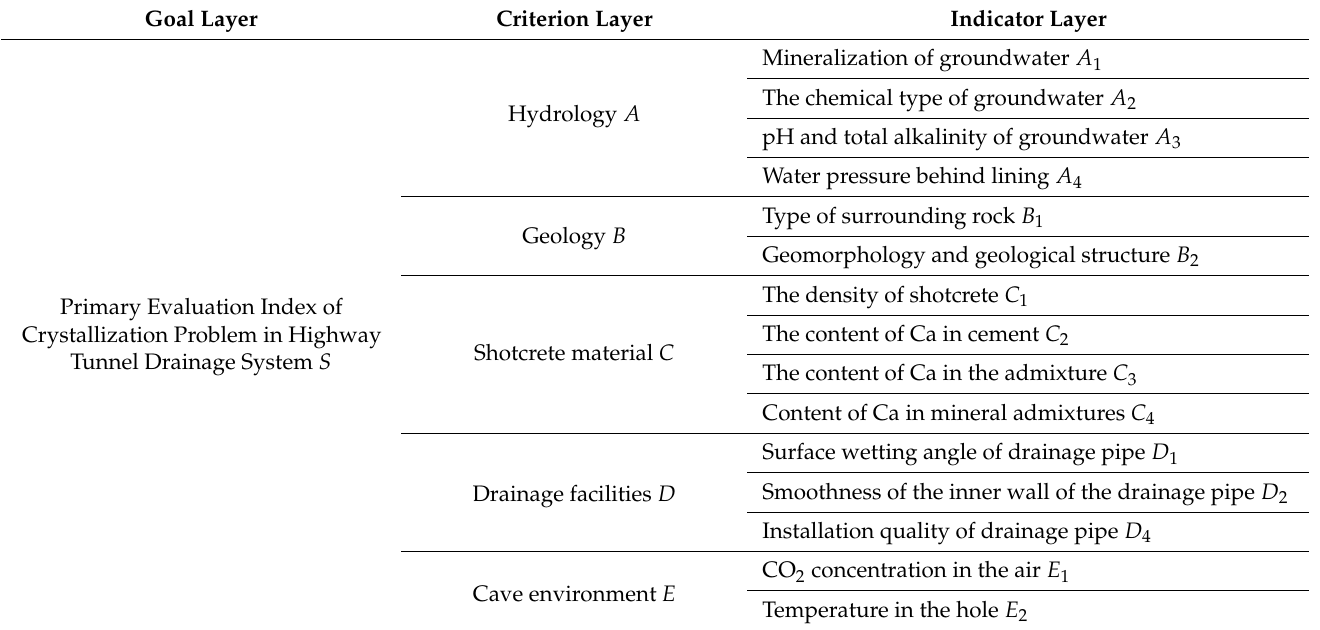
Table 5. A comprehensive list of indicators affecting the crystallization of drainage systems in mountain tunnels.